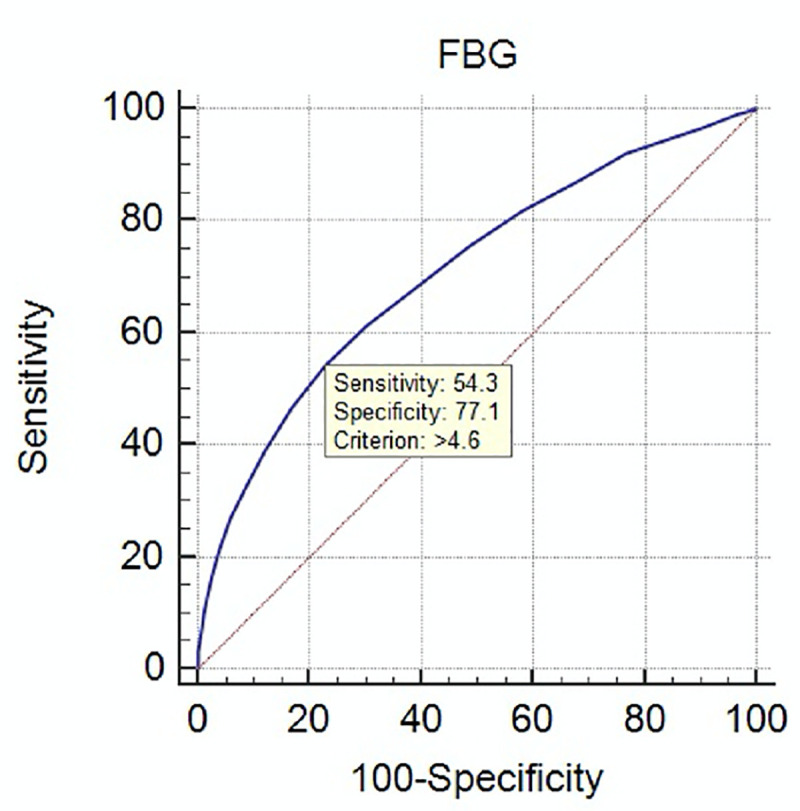
ROC analysis of FBG and elevated post-load BGLs.Shown is the ROC analysis (MedCalc statistical software) for the diagnosis of GDM based on elevated 1-hr and/or 2-hr BGLs on 75 gm OGTT for FBGs from 3.0 to 6.0 mmol/l. At FBG above 4.6 mmol/l, the sensitivity was 54.3% and specificity of 77.1%.